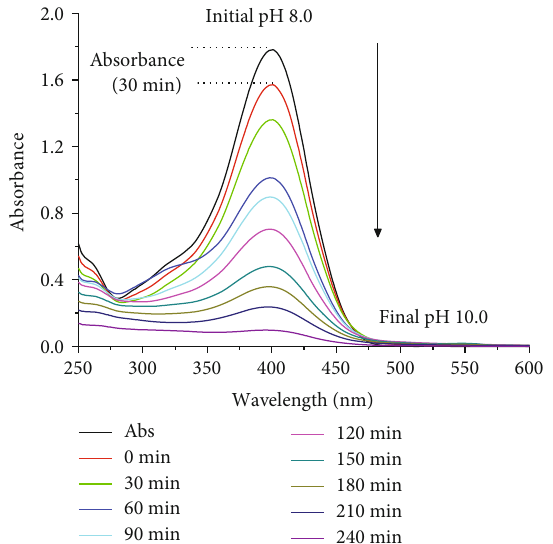
Figure 8: A set of UV-vis spectra of p -nitrophenol aqueous solution recorded at various degradation times in the presence of the W-TiO /SiO catalyst. The pH value of the solution varied from 2 2 an initial pH = 8 to pH = 10 after 240 min of